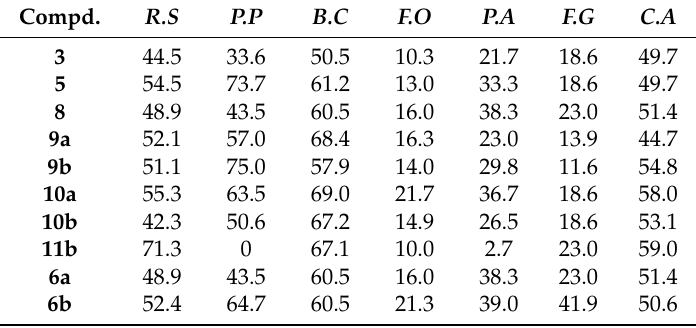
Table 1. The antifungal activities of compounds against phytopathogens (inhibitory rate, %) at 50 µg/mL a . Compd.